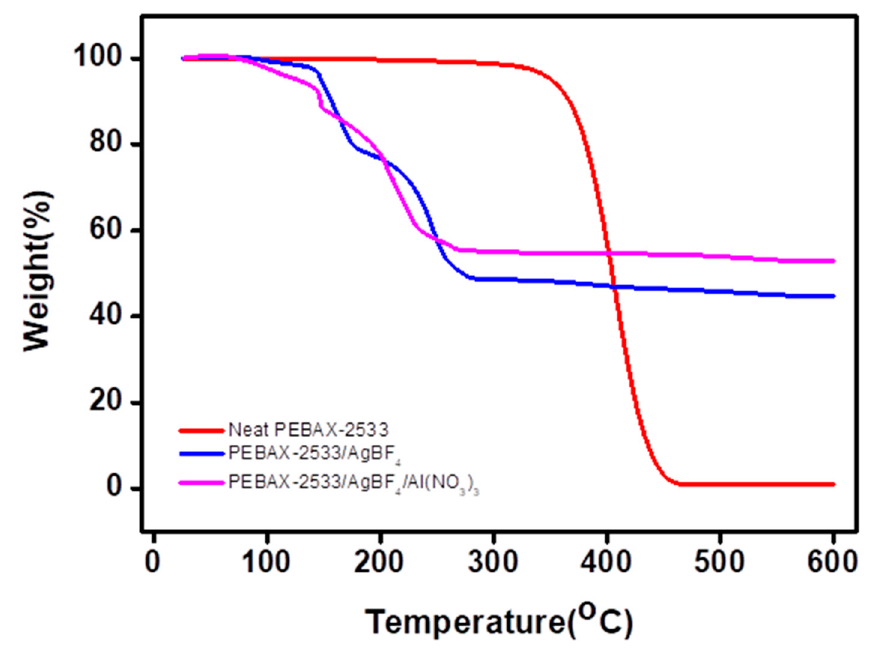
Figure 6. TGA curves for neat PEBAX-2533, PEBAX-2533/AgBF4 and PEBAX-2533/metal salt/Al salt complex.